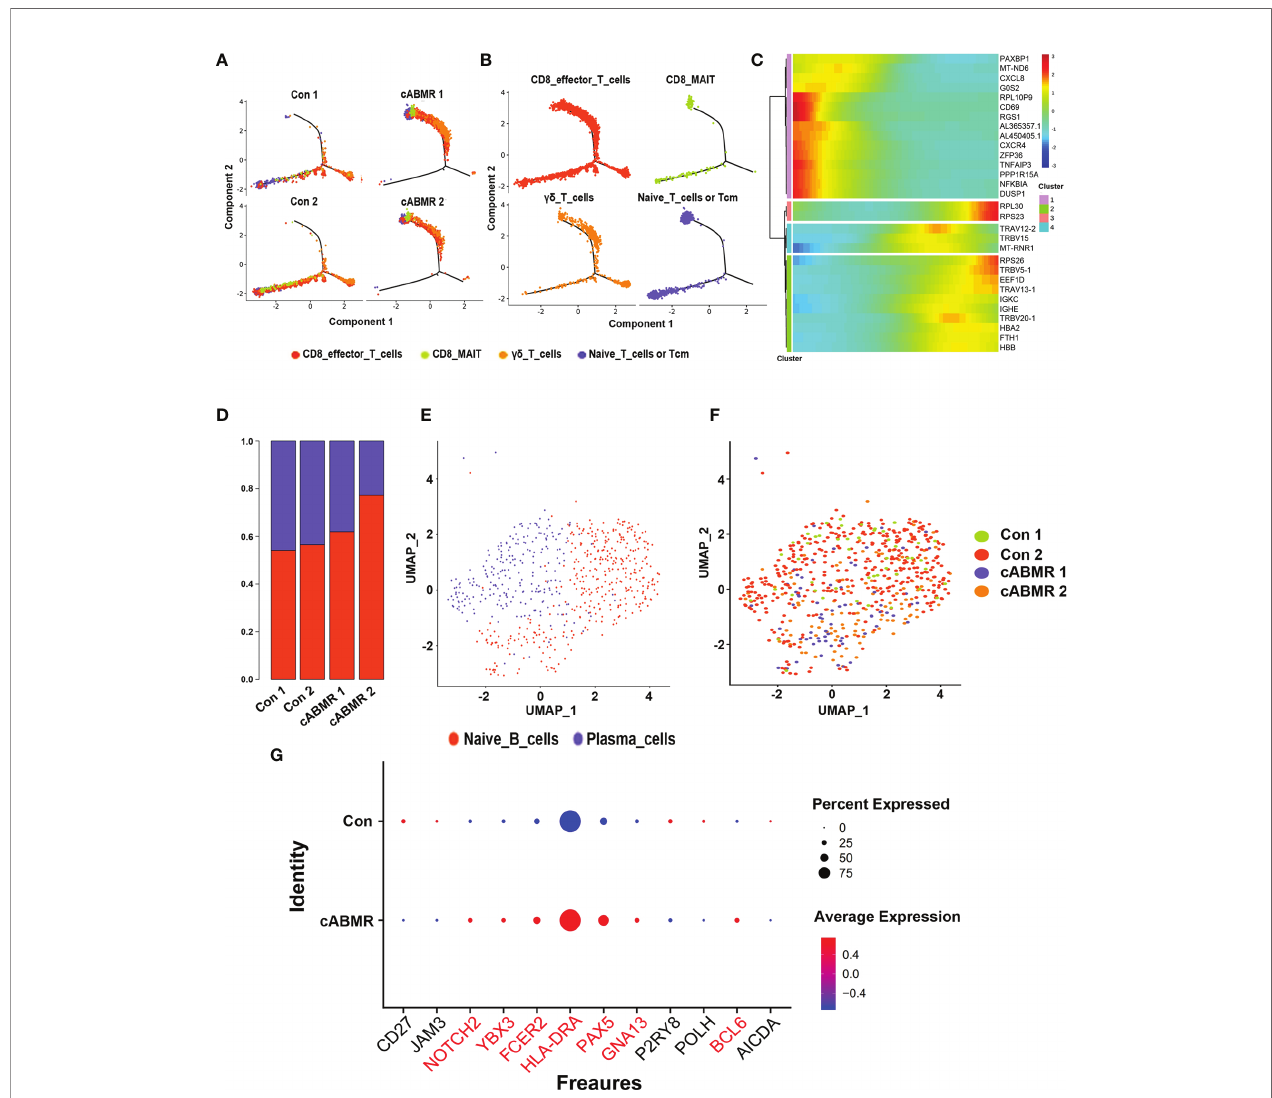
FIGURE 5 | Trajectory analysis of T cell subsets and Immunological characteristics of B cell subsets. (A, B) T cell subsets (each subset after subdivision) pseudo time trajectory analysis; (A) is stained by group source, and (B) is stained by cell type source, each dot corresponds to a single cell; (C) Pseudotemporal gene- expression pro fi les of the DEGs in T cell subsets, excluding the ribosomal and mitochondrial genes; (D) The proportion of each subset of B cells in Control group (n=2) and cABMR group (n=2); (E, F) UMAP dimensional-reduction projection analysis of samples from the control group and the cABMR group, Among them, (E) is colored according to cell type, and (F) is colored according to sample source; (G) DEGs node maps of B cells in the control and cABMR